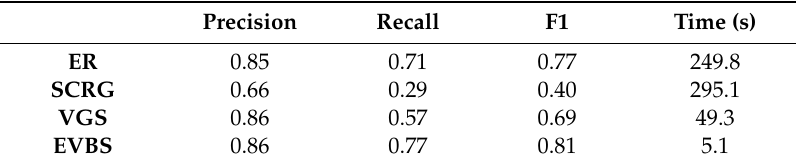
Table 3. Plane segmentation results using mobile laser scanner